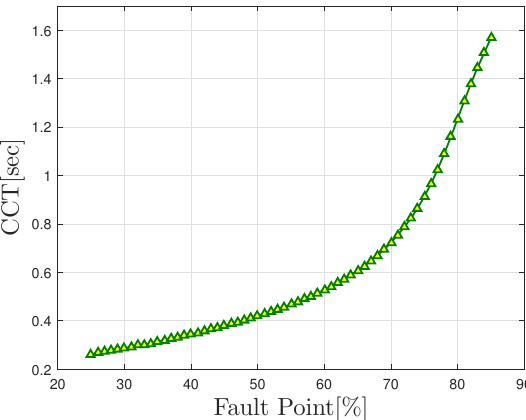
Figure 14. Power transmission line CCT data.